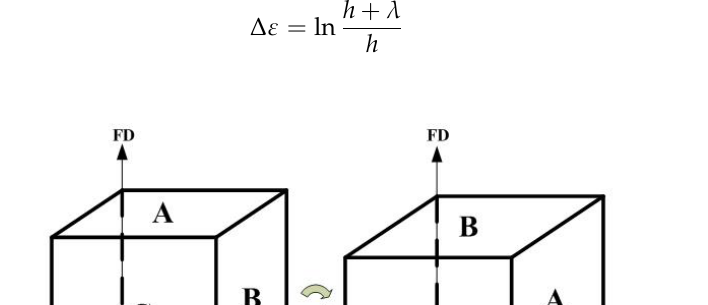
Figure 2. (0002), (101